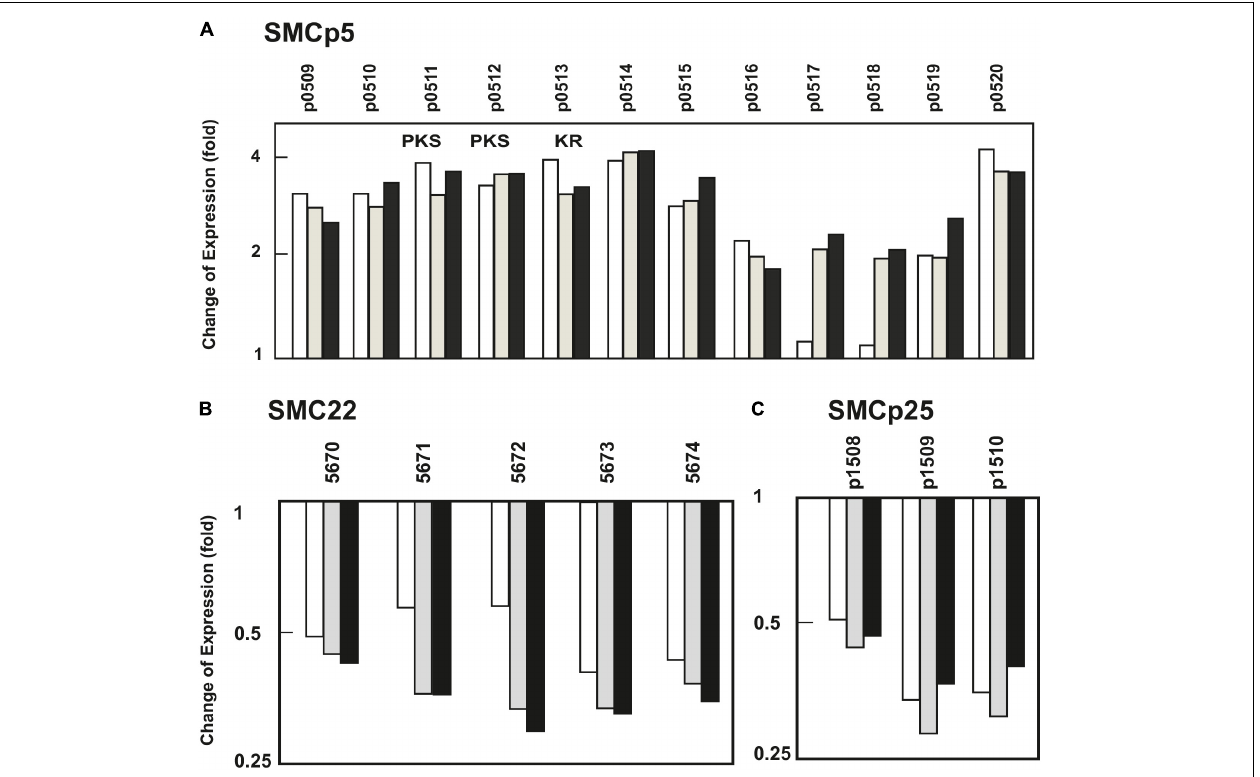
FIGURE 2 | Effect of PimM on the transcription levels of SMCp5, SMC22, and SMCp25. Change in the expression level of genes of (A) SMCp5, an upregulated gene cluster that encodes a PKS pathway, and two downregulated gene clusters, (B) SMC22 and (C) SMCp25, predicted to encode a terpene-like compound, and a clavam-like β -lactam, respectively. In the panels the columns represent the average of the expression fold-change at 84 h (white columns), 90 h (gray columns), and 96 h (black columns). Numbering of the SCLAV genes is indicated. Expression level values of S. clavuligerus :: pimM are compared to those of the control strain, S. clavuligerus ::pIB139, normalized as 1. Genes encoding polyketide synthases and ketoreductases are indicated by the letters PKS and KR,